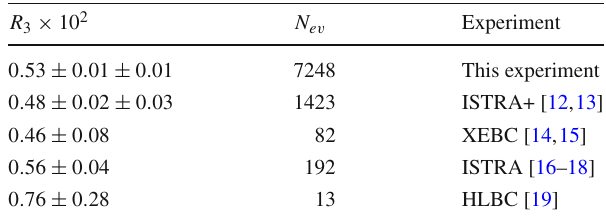
And for the cuts E ∗ γ > 30 MeV and (cid:5) ∗